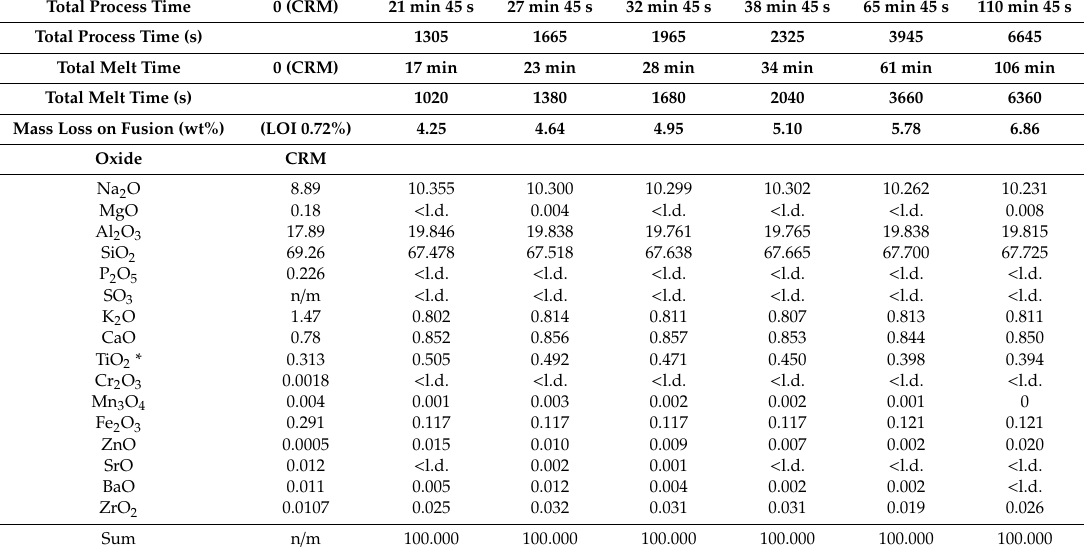
Table A3. XRF data for Soda Feldspar (CRM-375, [43]) as a function of total process and melt times. Data are single measurements; < l.d. = below limit of detection; n / m = not measured; * analysed TiO 2 content includes contribution from I L β 1,2,3